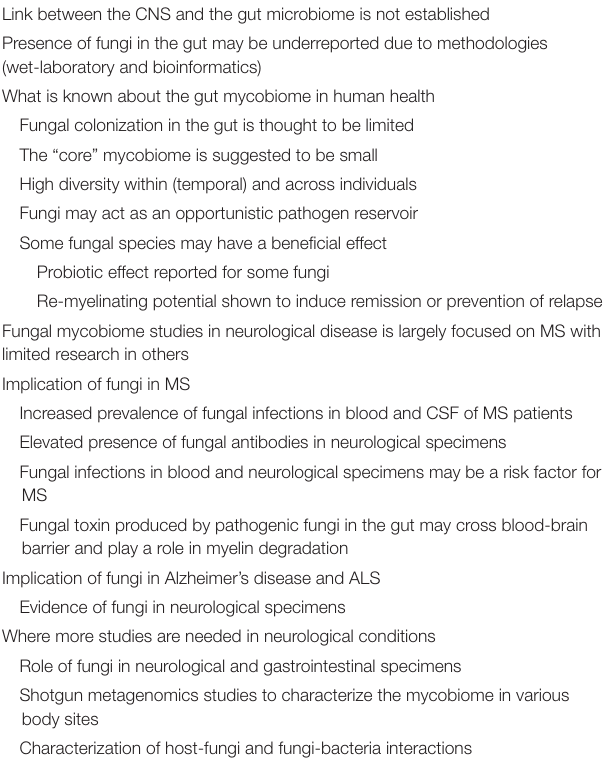
TABLE 1 | Key findings related to the gut mycobiome in neurological disease. Link between the CNS and the gut microbiome is not